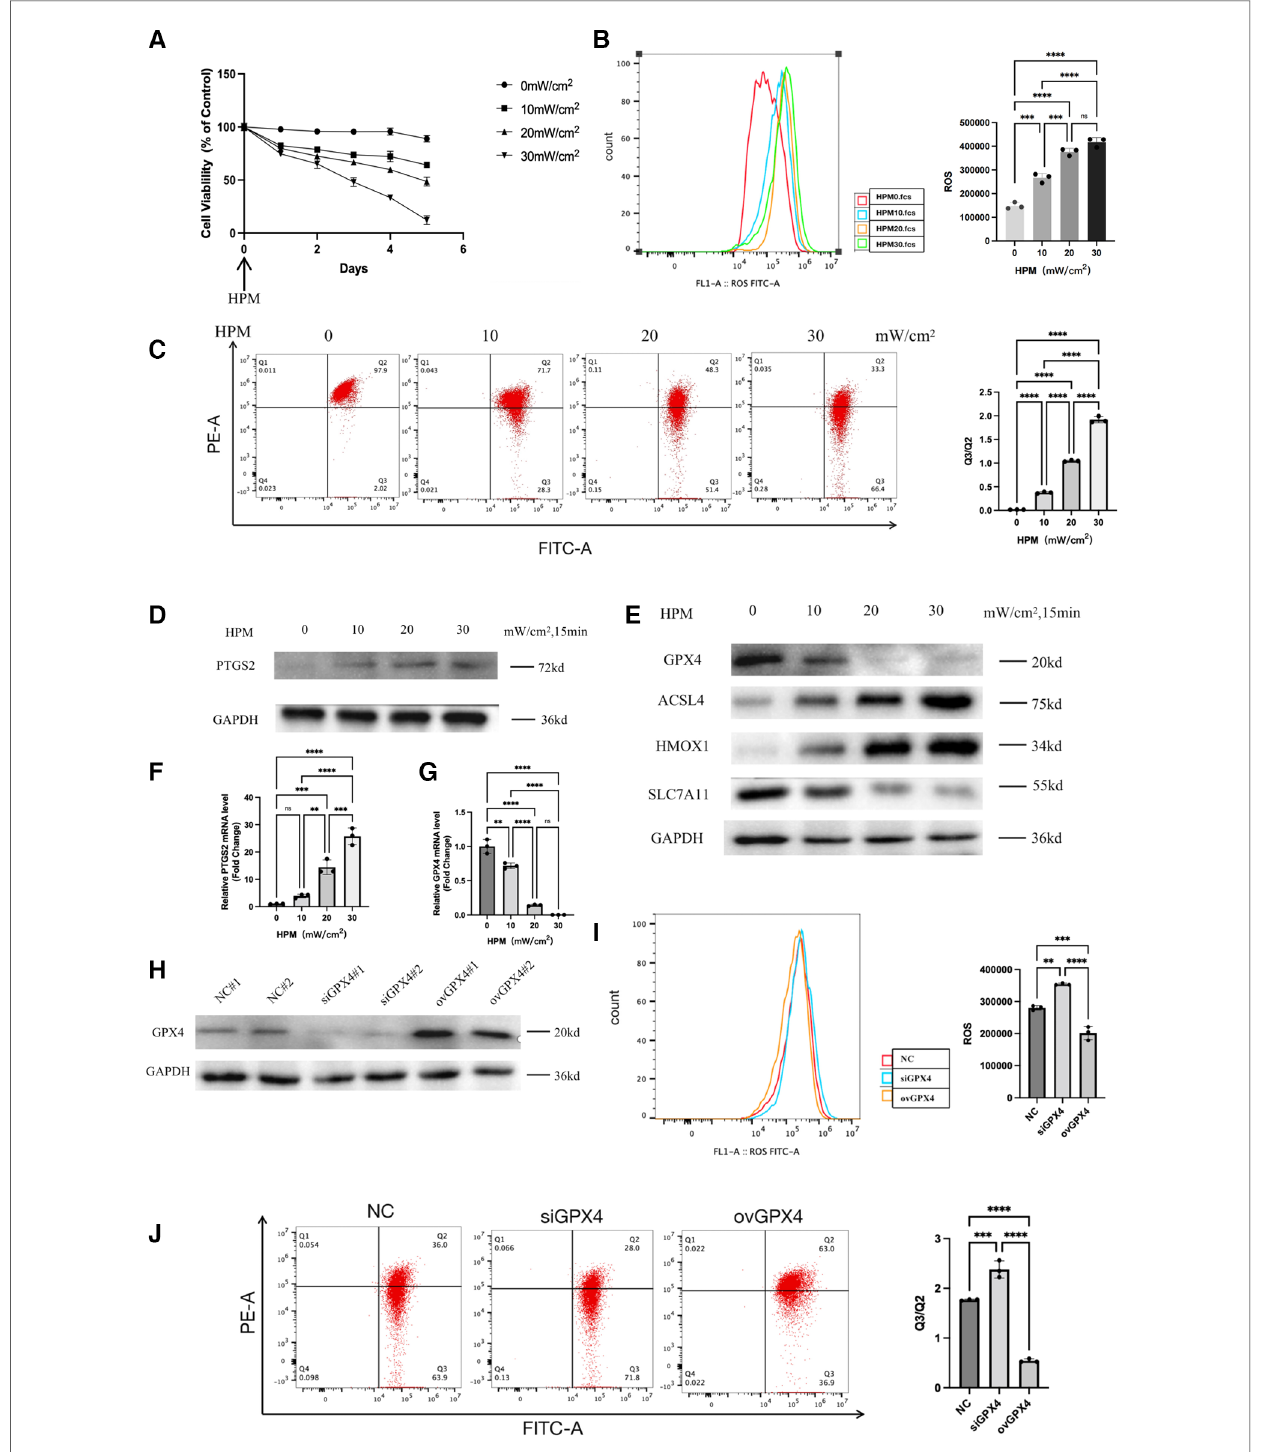
FIGURE 3 Ferroptosis occurs in the HPM cardiomyocytes. ( A ) Cardiomyocytes cells were treated with different HPM, and the cell viability was measured by MTS assay from 0 to 5 day after HPM. ( B ) ROS assay was performed in the cardiomyocytes treated with 4 concentrations of HPM for 15 min. Representative fl ow cytometry dot plots (left) for cardiomyocytes cells and quantitative analysis (right). Data represent mean±SD. ns, not signi fi cant; ***, P<0.001,****, P<0.0001, one-way ANOVA, post hoc comparisons, Tukey ’ s test. ( C ) JC-1 Mitochondrial Membrane Potential Assay Kit performed in the cardiomyocytes. ( D,E ) Protein levels of PTGS2, GPX4, HMOX1, ACSL4, SLC7A11 from the cardiomyocytes were analyzed with Western blot. ( F, G ) qRT-PCR analysis of PTGS2, GPX4 mRNA level was done in the cardiomyocytes. **, P<0.01, one-way ANOVA. ( H ) Cardiomyocytes stably transduced with GPX4-siRNA and overexpression constructs and then subjected to Western blot. ( I,J ) ROS assay and JC-1 Mitochondrial Membrane Potential assay were performed in the control, siGPX4, ovGPX4 cardiomyocytes. Representative fl ow cytometry dot plots (left) and quantitative analysis (right). Data represent mean±SD. ns, not signi fi cant; ***, P<0.001, **, P<0.01, one-way ANOVA, post hoc comparisons, Tukey ’ s